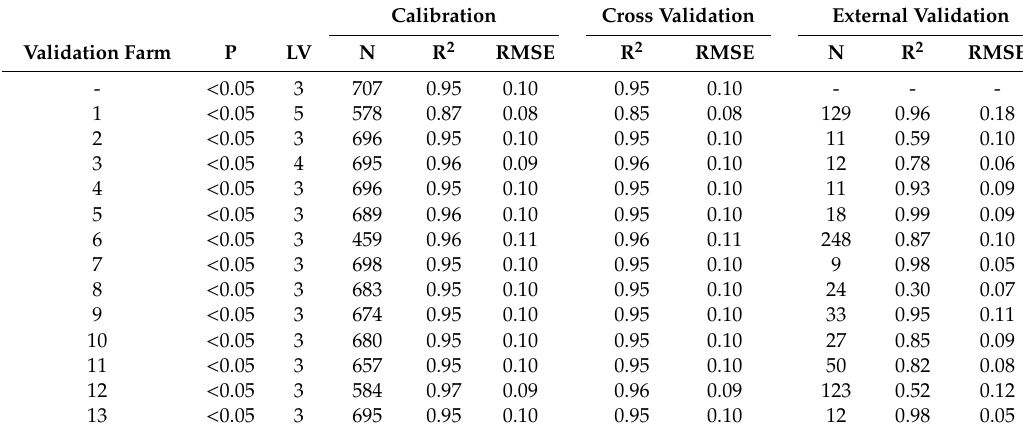
Table 3. Results of leave-one-farm out external validation of orthogonal partial least squares (OPLS) regression models predicting serum BHBA concentration from uncorrected 1 H NMR spectra. Validation farm specifies the identity of the data used for validation, N the number of animals used in calibration and validation datasets. The coe ffi cient of determination (R 2 ) and root mean square error (RMSE) are reported for each calibration / validation subset.